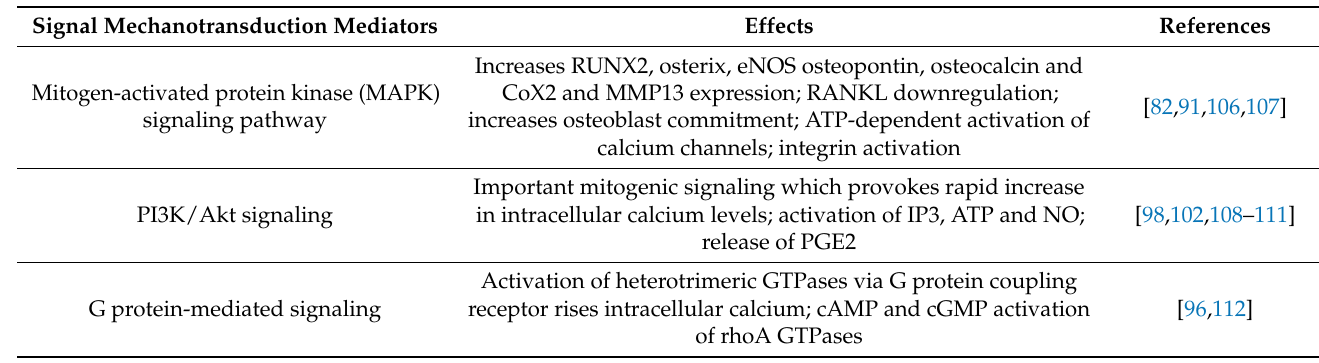
Table 2. Mechanotransduction signaling. When a bone is mechanically loaded, cells detect the physical deformation, converting the perceived mechanical strain signal into a biological output (i.e., a cellular response). Although the precise biochemical pathways have yet to be fully unraveled, different response pathways have been reported to mediate the adaptative response to mechanical loading and unloading in bone. Signal Mechanotransduction